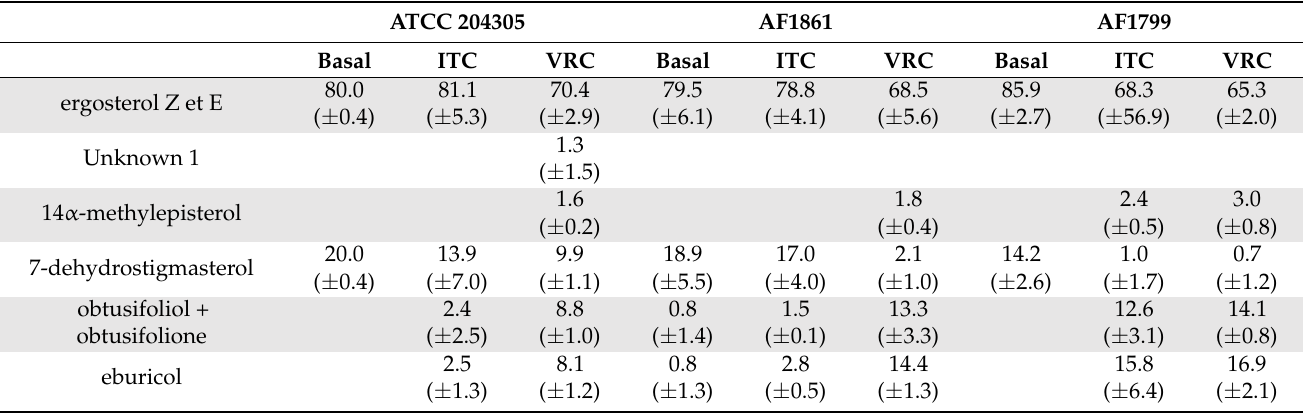
Table 3. Relative composition of sterols of group 1, azole-susceptible strains, under basal conditions or after in vitro exposure to itraconazole (ITC) or voriconazole (VRC) (concentration = 0.25 × MIC). Values are expressed as the mean of three independent experiments, standard deviation is given in brackets.